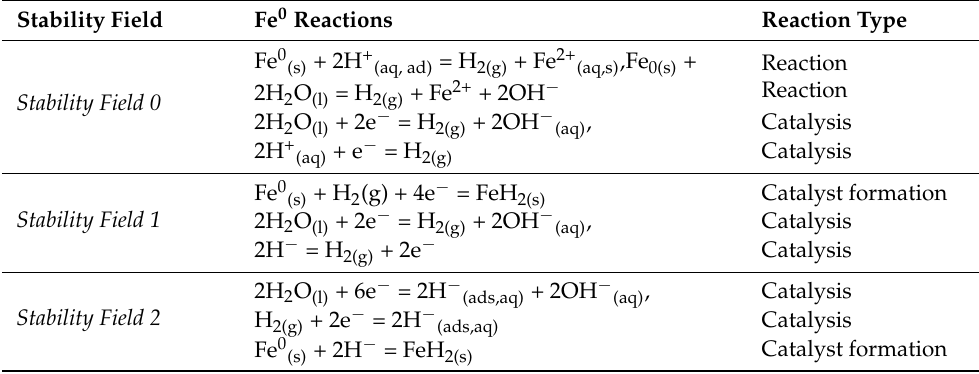
Table 12. Fe 0 reactions, catalysis, and catalyst formation within the different redox stability fields. Catalyst formation occurs in Stability Field 1 and Stability Field 2 .